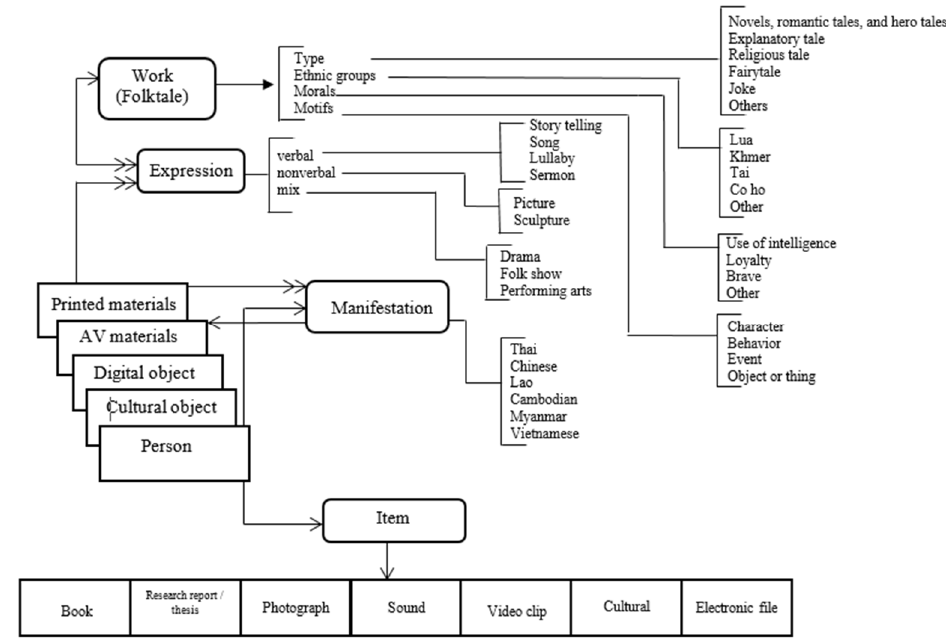
Figure 1. Functional requirements for bibliographic records conceptual model of the elements of folktales in Mekong River Basin.